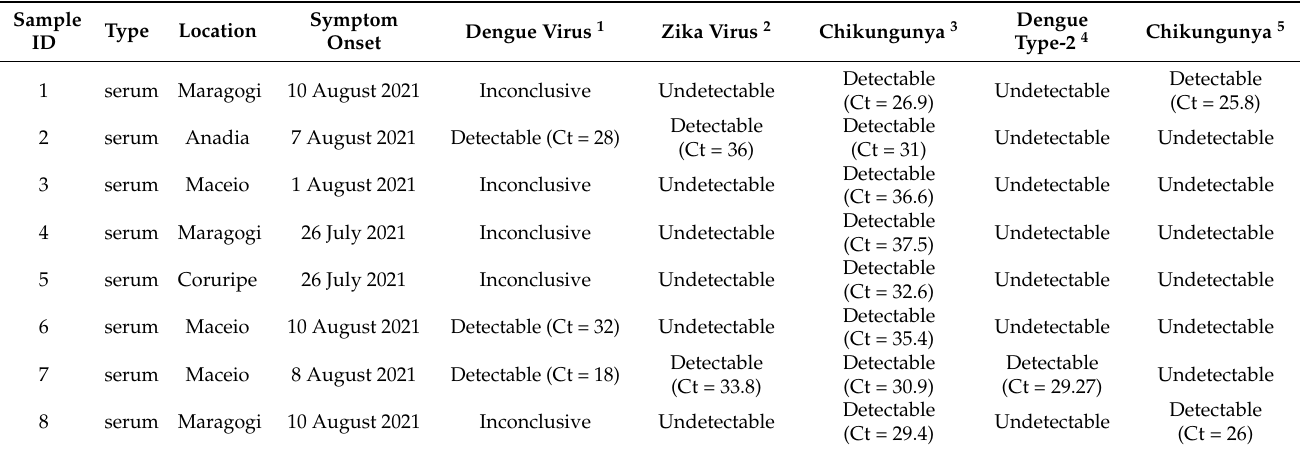
Figure 1. Area of investigation and metagenomic analysis of the analyzed pool of samples. ( A ) Map representing the spatial area under investigation and position of state of Alagoas in Brazil. ( B ) Bar- plots illustrating the relative abundance of viral reads for the most presented viral agents in the metavirome of the tested patients with predominance of Chikungunya and Dengue viral reads and other commensal viruses, forming part of the normal metavirome. ( C ) Circular representation of the relative viral abundance; Chikungunya and Dengue viruses are highly present. Table 1. Characteristics of the tested samples and their amplification profile.